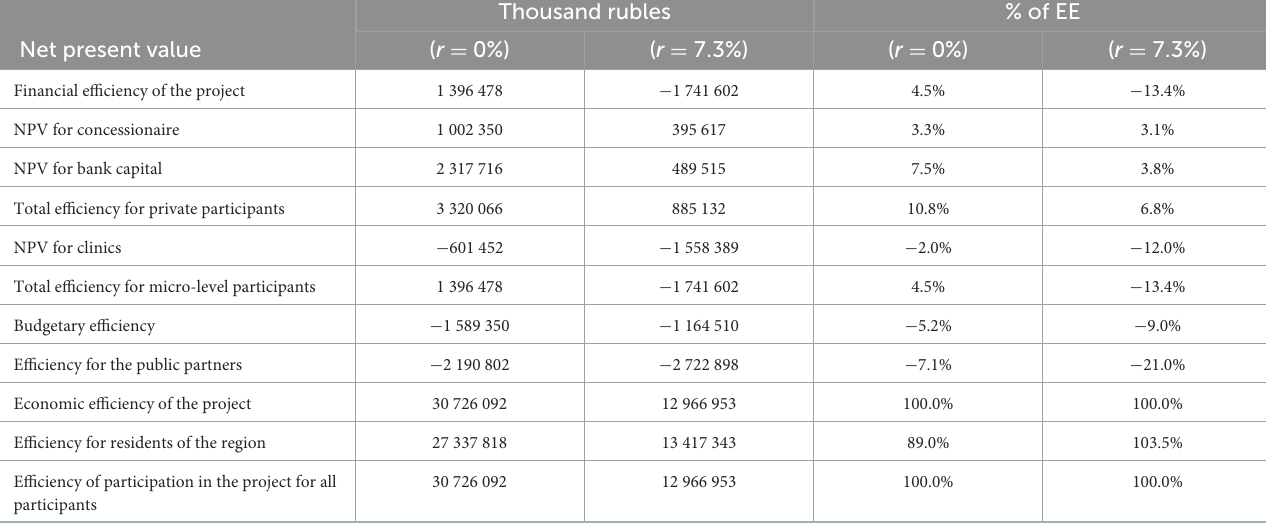
TABLE 7 The relationship between the efficiency of the project and participation in the